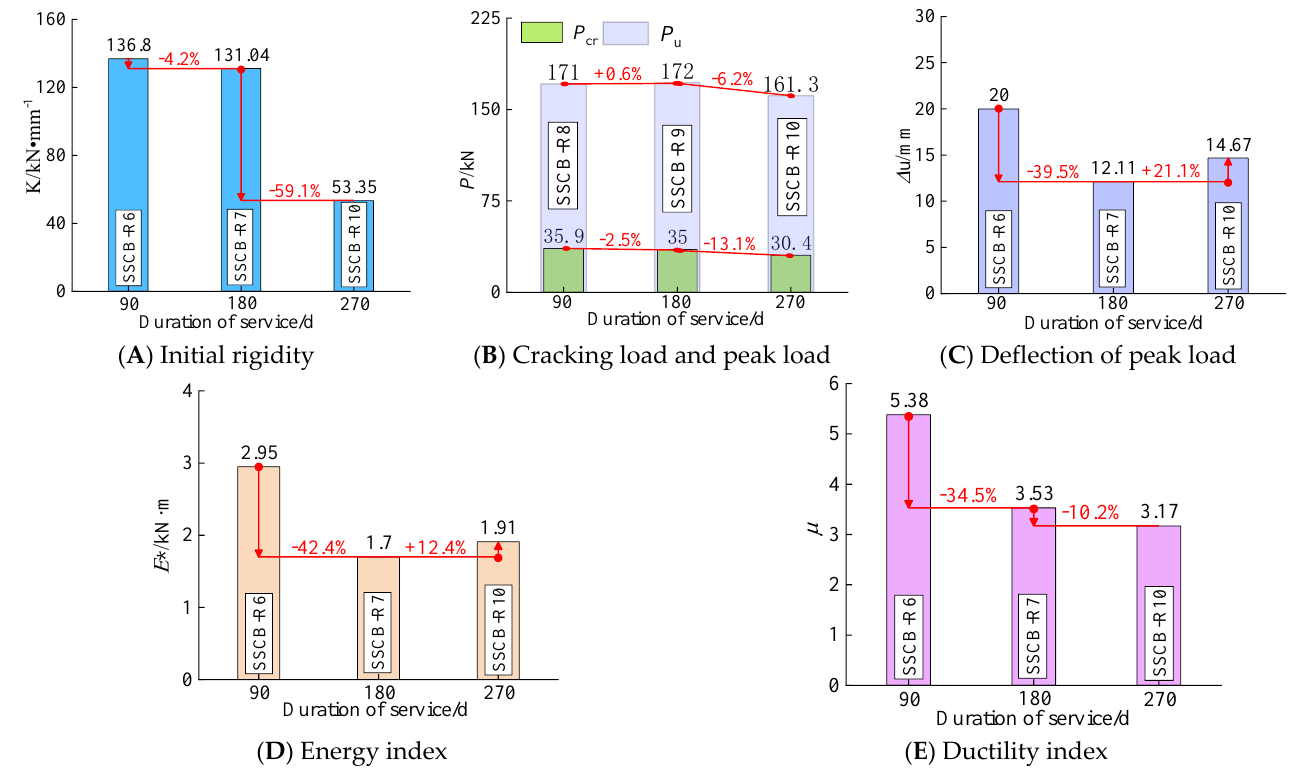
Figure 11. The performance indexes vary with duration of service.